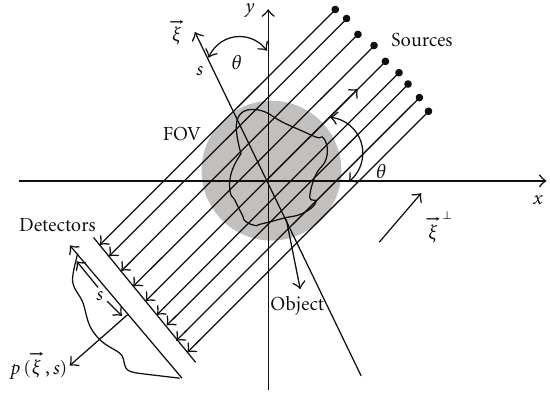
Figure 1: Parallel-beam